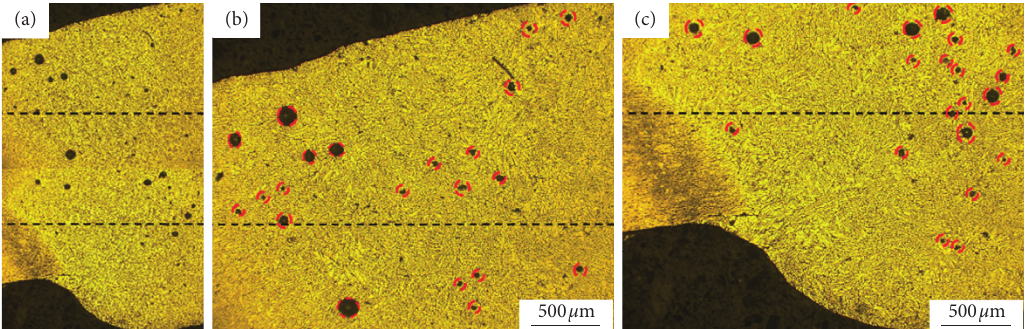
Figure 9: Schematic diagram of cross section of WJ. (a) Cross section of WJ. (b) Partial enlargement of cross section.